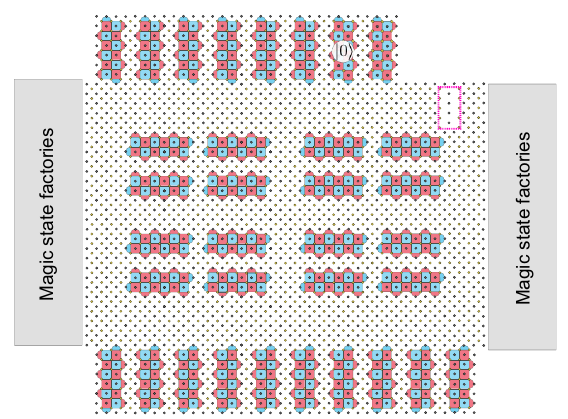
FIG. 15. A small example of a quantum computer layout, with a core composed of four unit cells (and therefore 16 surface-code patches); cache on the top or bottom edge of the core; and magic state factories on the left or right of the core. A pink dashed rect- angle in the top-right corner indicates a hardwired lattice defect so as to enable twist-free lattice surgery.